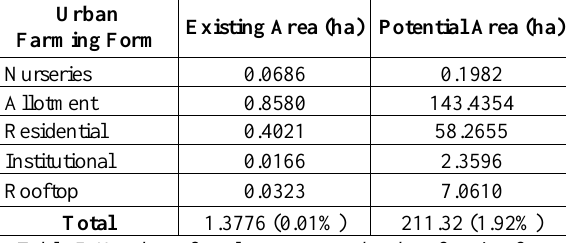
Table 5. Number of total areas per each urban farming